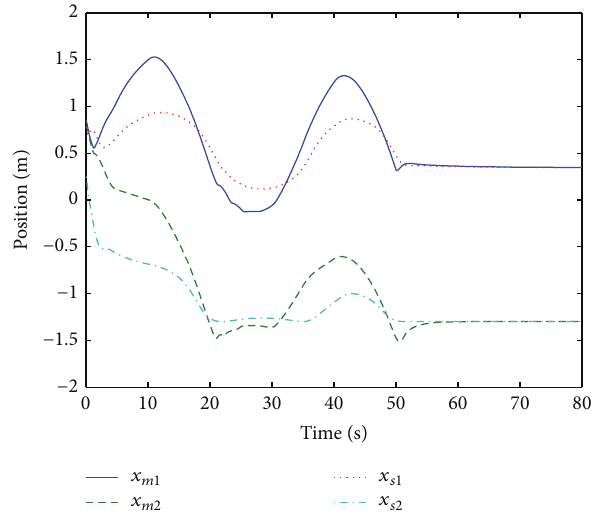
Figure3:Thepositionsofthemasterandtheslaveintaskspacewith the known gravity term.